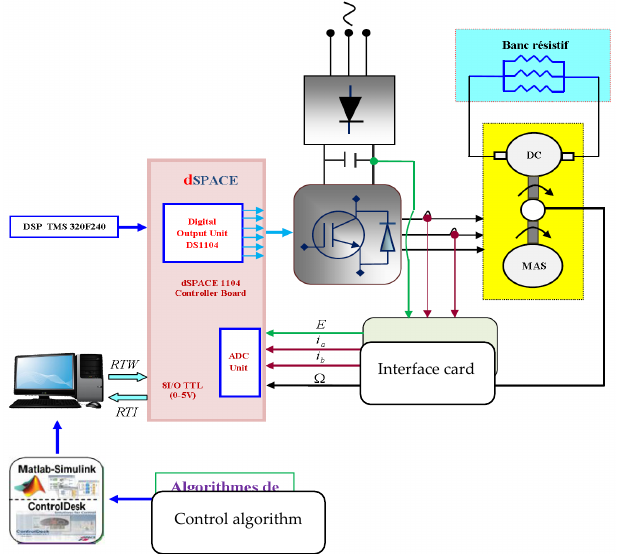
Figure 12. Structure of the experimental platform.